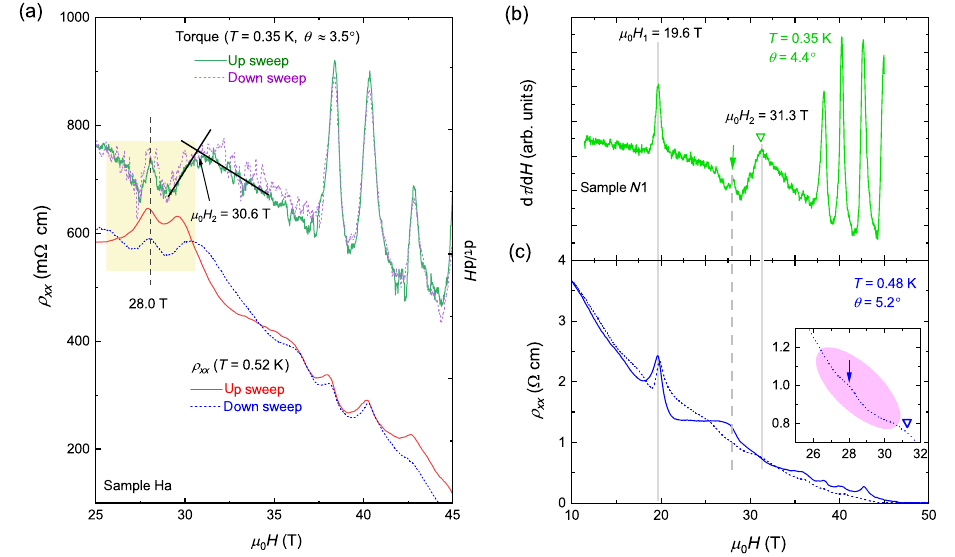
FIG. 12. (a) Magnetic field dependence of MR and d τ =dH for the YbB 12 sample Ha, with the magnetic field close to the [001] direction. Solid and short-dashed lines represent data curves taken during field up sweep and down sweep, respectively. To be noted, two wiggles appear between 25.5 and 30.5 T (yellow shaded region) with the peaks and valleys well aligned between ρ are quantum oscillations. In particular, the signature at 28 T (vertical dashed line) should be a SdH peak. An abrupt slope change of d τ =dH at 30.6 T, on the other hand, is likely to be a Lifshitz transition. Magnetic field dependence of (b) d τ =dH measured at T ¼ 0 . 35 K for tilt angle θ ¼ 4 . 4 °, (c) MR at T ¼ 0 . 48 K for θ ¼ 5 . 2 °. Data in (b) and (c) are measured in sample N 1 . Solid and short- dashed lines in (c) are up sweeps and down sweeps, respectively. Characteristic fields μ 0 H 1 ¼ 19 . 6 T (manifested by prominent peaks in both d τ =dH and MR) and μ 0 H 2 ¼ 31 . 3 T (a sharp kink in d τ =dH ) are denoted by vertical solid gray lines. The feature appearing at 28 T in both d τ =dH and MR (arrow and dashed vertical line) originates from quantum oscillations. Inset of (c) is an expanded view of ρ between 25 and 32 T. The light magenta shaded area indicates the field range at which hints of a weak SdH effect can be seen on the down sweep. The down triangle marks the position of μ 0 H 2